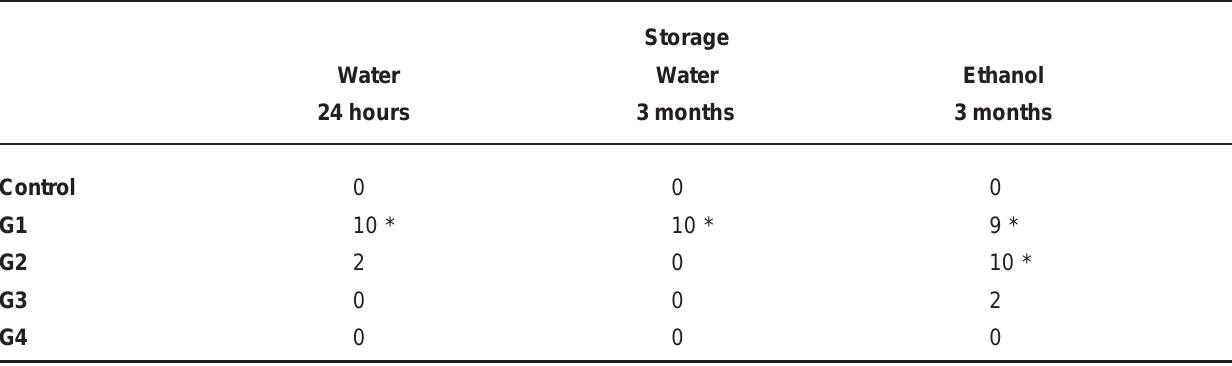
TABLE 2- Number of specimens out of 10 that showed mainly adhesive failure. Values marked with an asterisk (*) are significantly different from the control group (p <